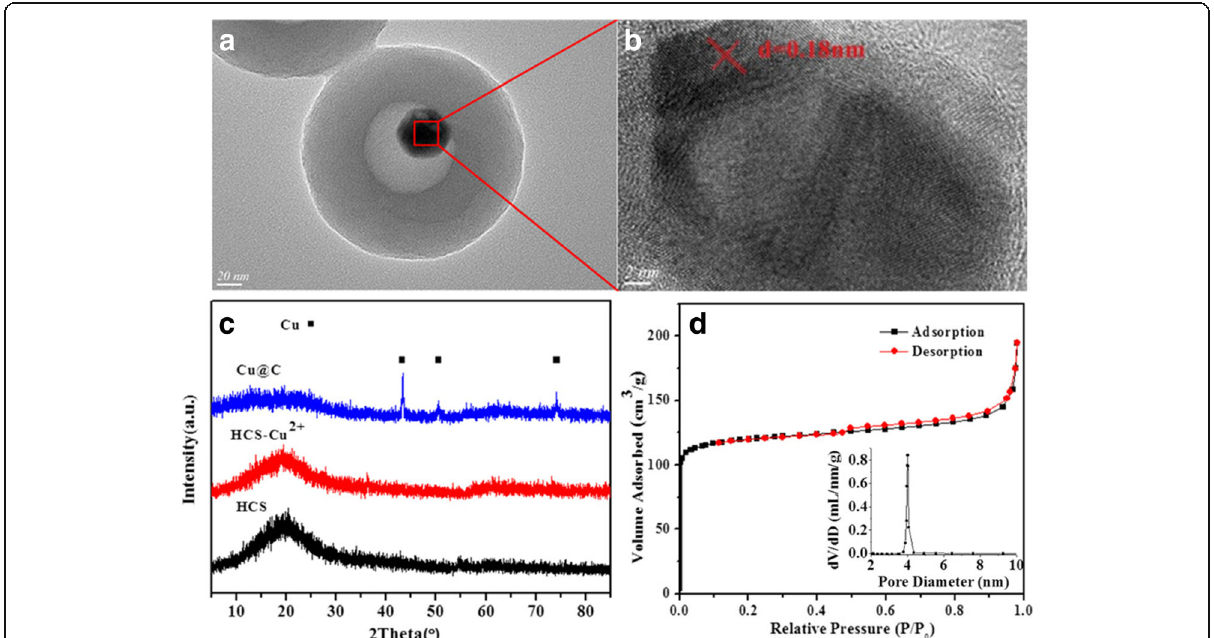
Fig. 3 a , b TEM images of copper core in Cu@C-0.12. c XRD patterns of the products obtained after each step: HCS, HCS-Cu 2+ , and Cu@C-0.12. d N 2 adsorption-desorption isotherm and distribution of pore size of Cu@C-0.12